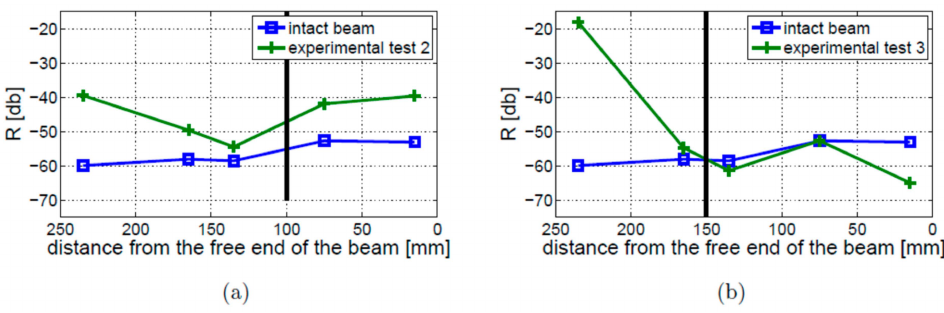
Figure 24. Values of R coefficient for the free–free boundary conditions: ( a ) Experimental Test 2; ( b ) Experimental Test 3. Both results are compared with the intact beam results. The crack location is indicated by the vertical solid black